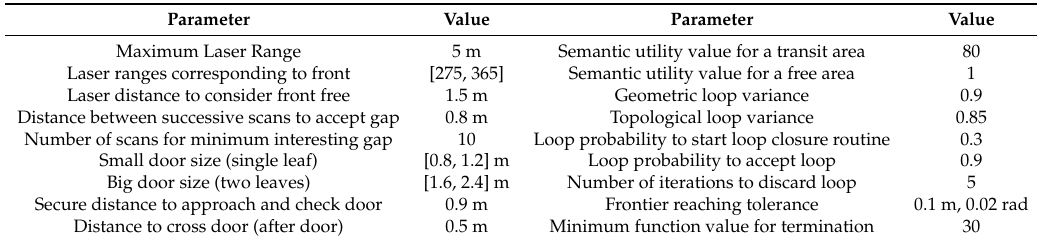
Table 3. Set of parameters used for the experimental